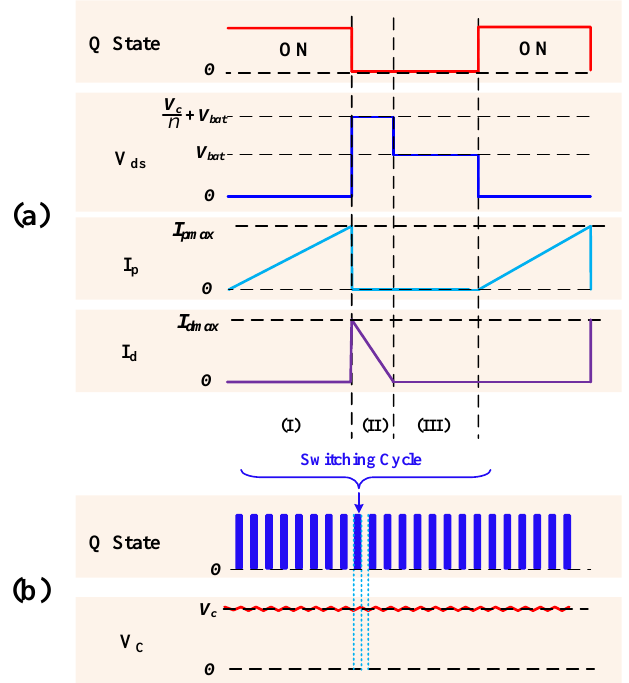
Figure 5. Switching waveforms of the flyback converter during ( a ) one switching period; ( b ) steady-state operation.